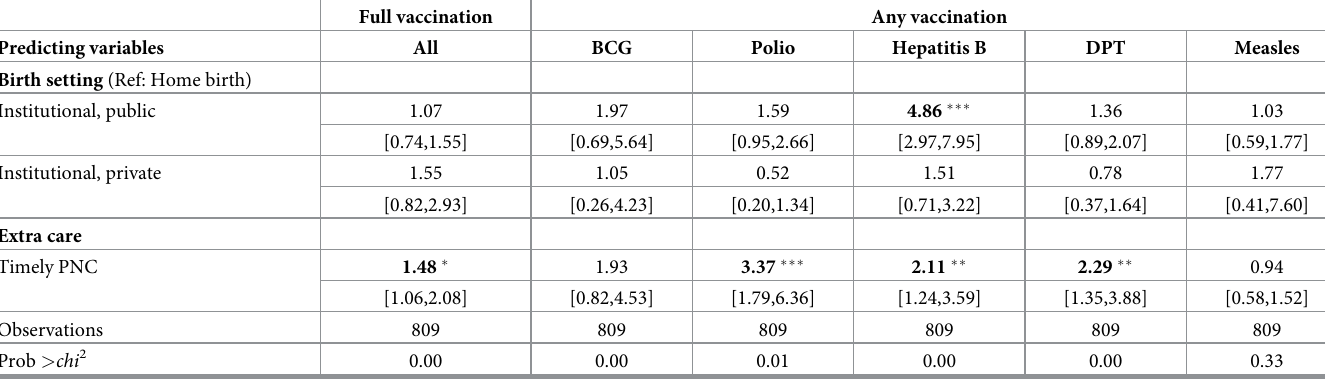
Table 4. Association of perinatal care (birth setting and timely PNC) with the vaccination status of children aged 10–20 months in Bihar. Full